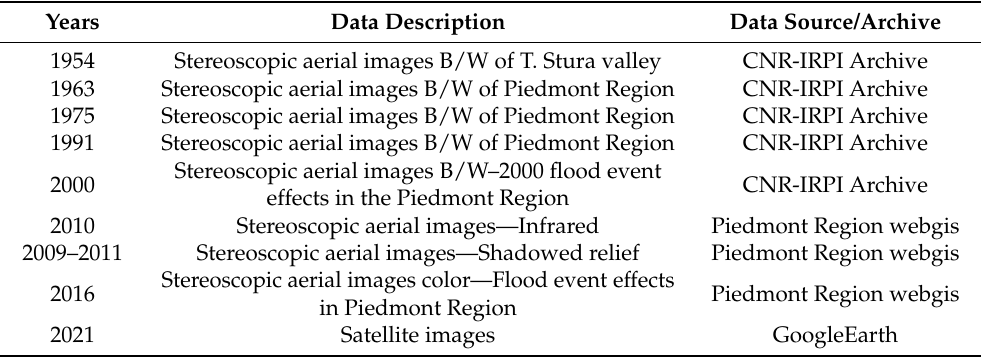
Table 2. Detail of the data image source.